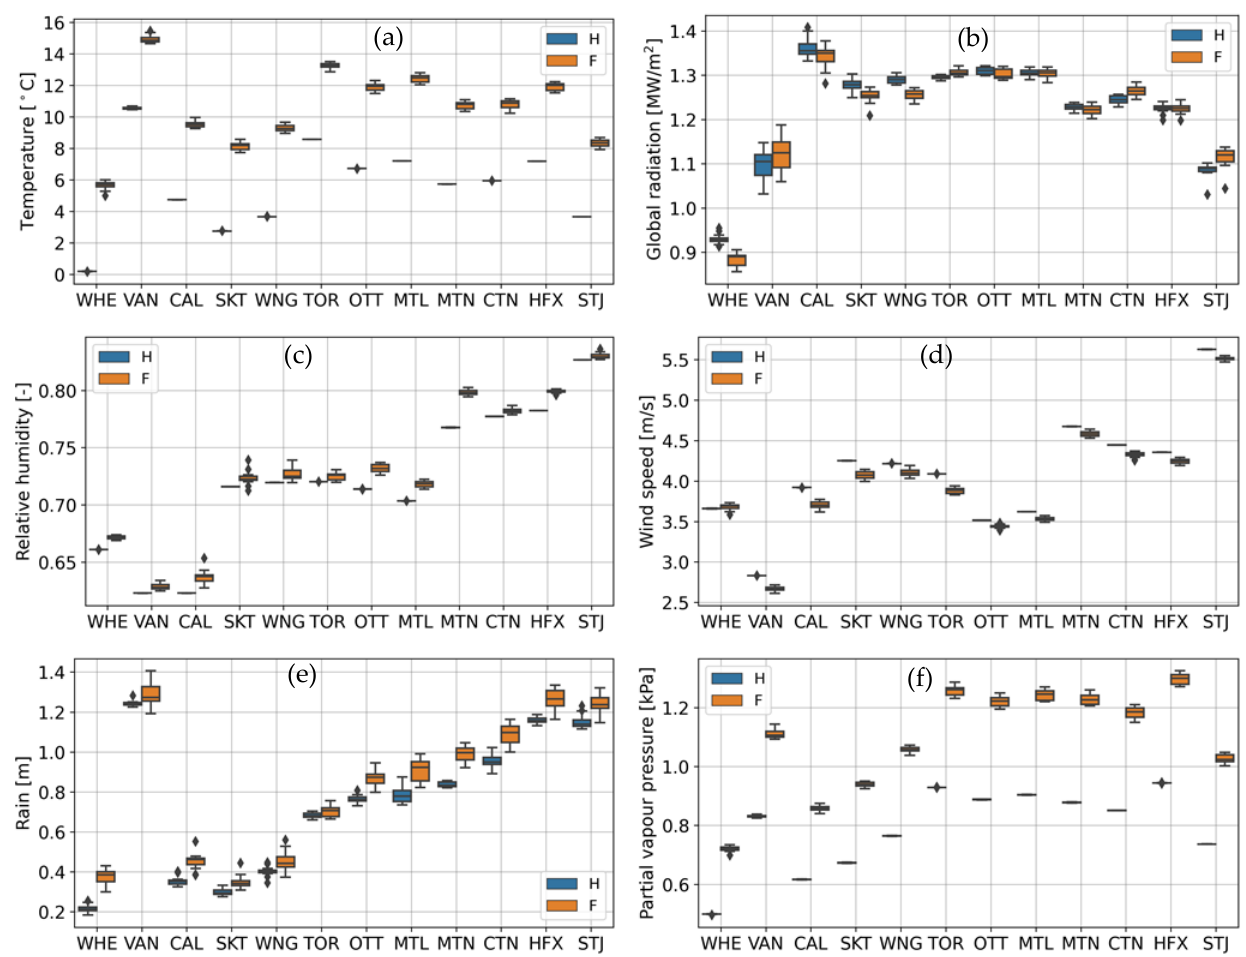
Figure 3. Boxplots of the run means of the yearly mean values of temperature ( a ), relative humidity ( c ), wind speed ( d ), and partial vapor pressure ( f ), and yearly sums of horizontal rain ( e ) and global radiation ( b ) for historical (H) and future (F) time-periods in the 12 cities studied. For each city, the left and right boxes are H and F, respectively.